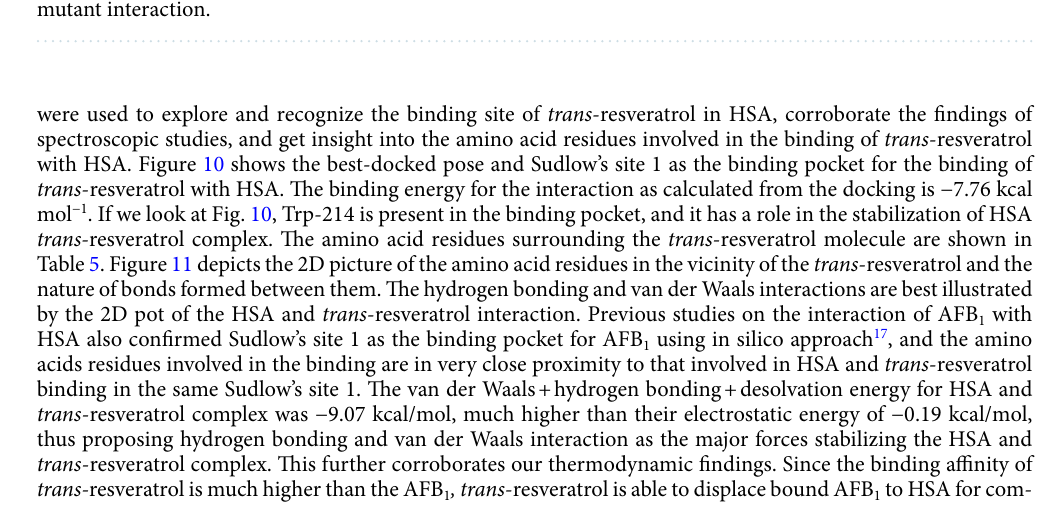
Table 5. Docking parameters like binding energy and amino acids involved in T-res-HSA and T-res- HSA mutant interaction.